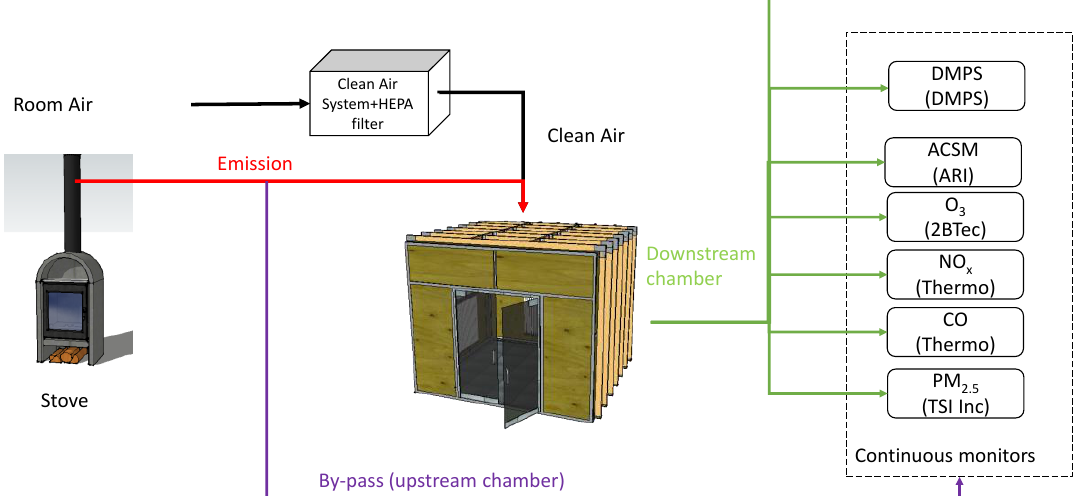
Figure 1. Photochemical chamber set up. The whole experiment was located inside a laboratory of the Center for Vehicle Control and Certification.